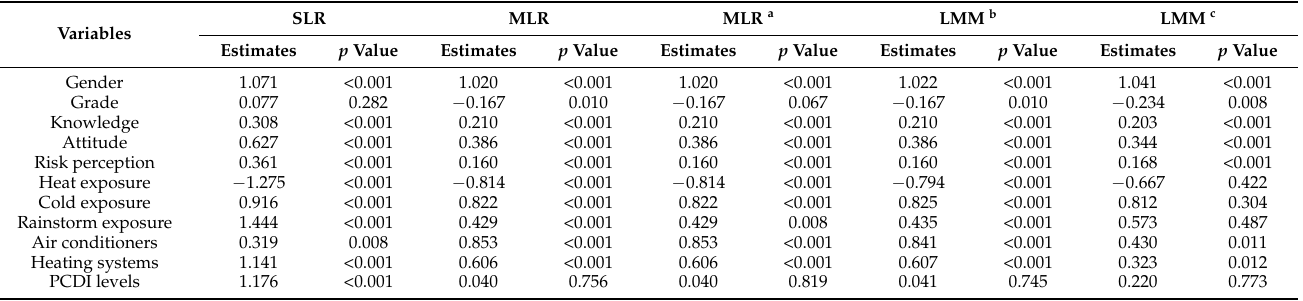
Table 3. Influencing factors of adaptive behavior of climate